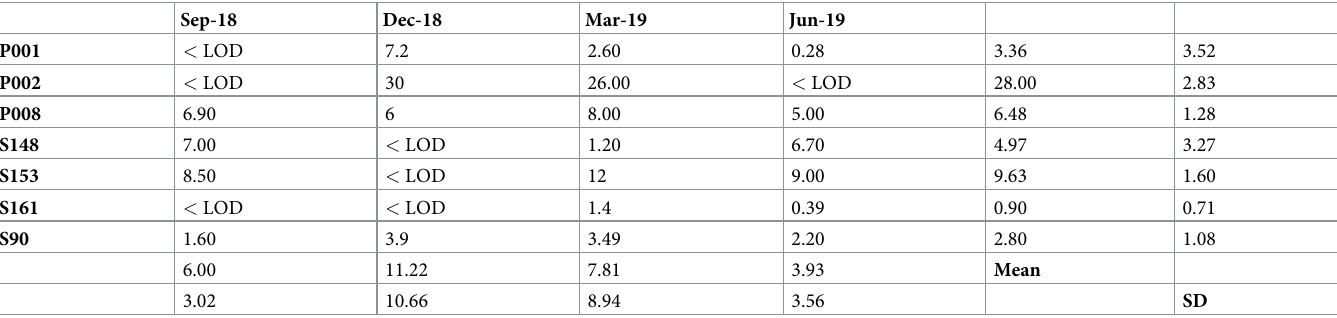
Table 3. Nitrate concentrations showing mean and standard deviations (SD) in the investigated springs (mg/L NO 3- ).